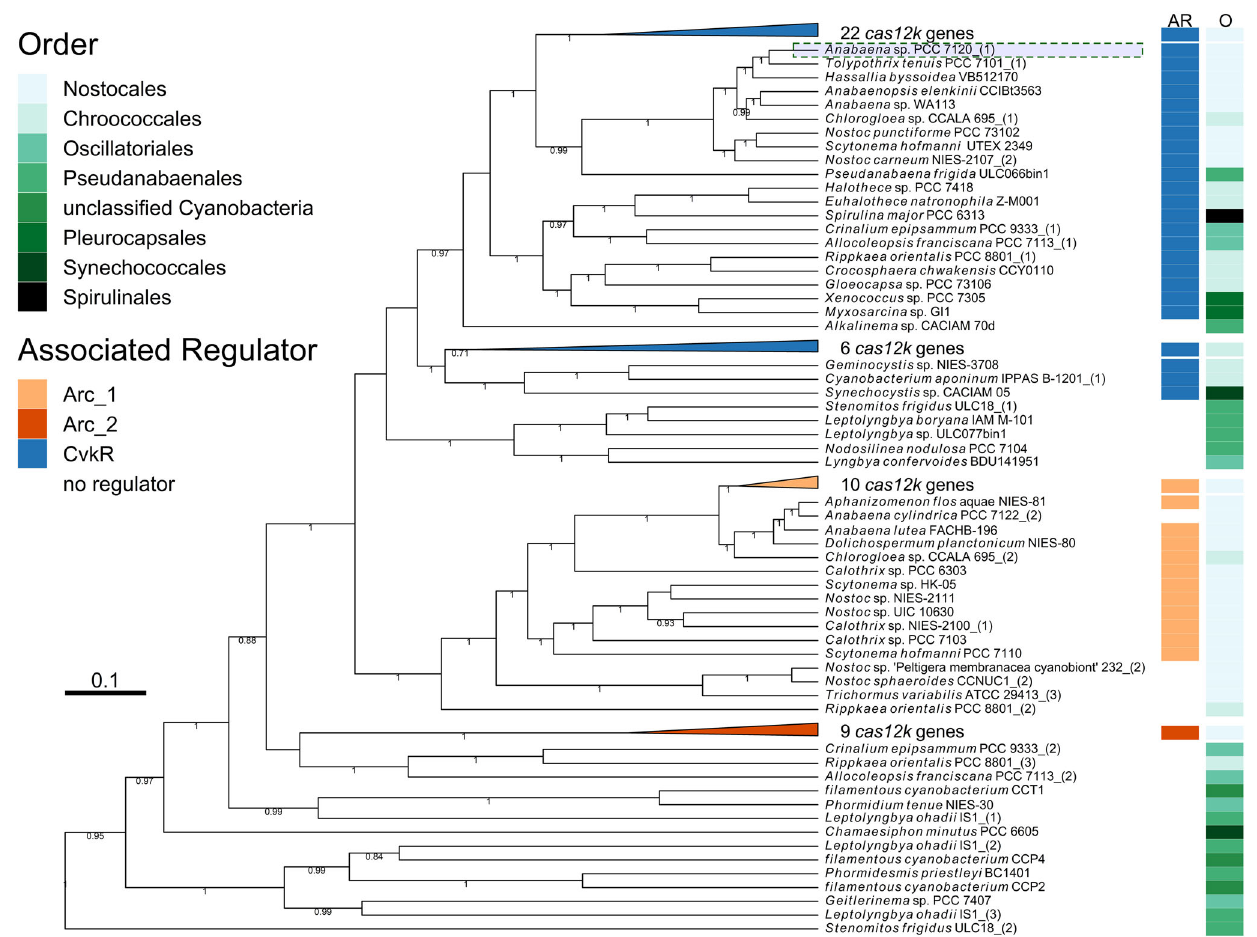
Fig. 2 | Phylogenetic analysis of Cas12k homologs. The identi fi ed 106 complete Cas12k proteins were aligned using M-coffee 74,75 and analyzed by BEAST 76 . Twelve instances of degenerated Cas12k proteins were intentionally left out to avoid mis- interpretation. The resulting tree is depicted with branches labeled with their respective posterior probability if ≥ 0.7. For better recognition, the proteins were labeled with their respective host organism (further details in Supplementary Data 1). The associated regulator type (AR) and taxonomic order (O) of the